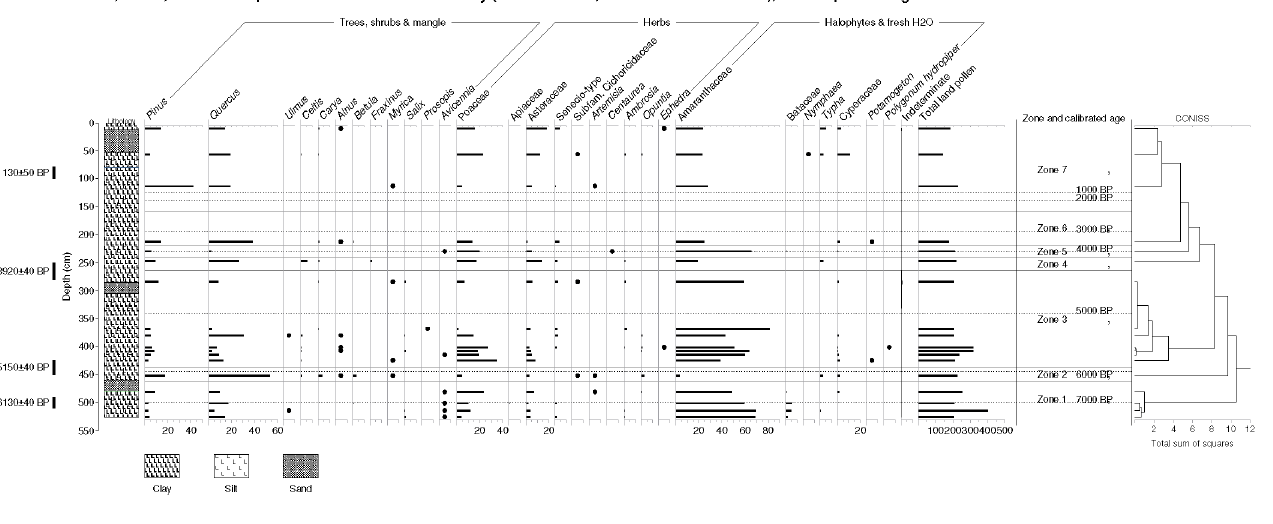
Figure 6. Swan Lake (SL) relative pollen diagram (percentage of TLP) and Troels-Smith lithology. Note redox features and pollen hiatus 130–280 cm and absence of pollen samples in sand layers.